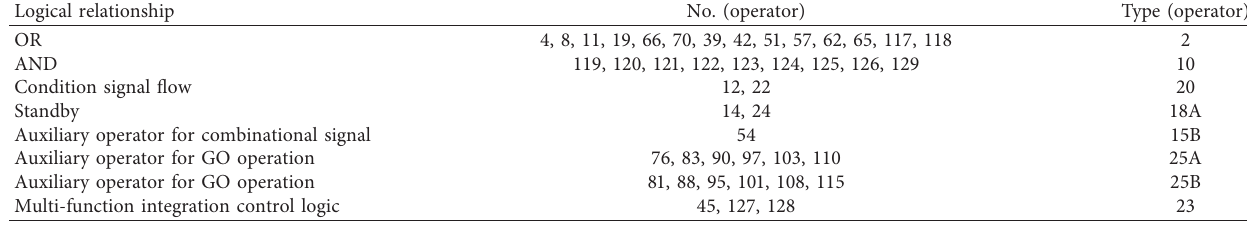
Table 11: Logical GO operator and auxiliary GO operator in the GO model of PSSTCS.